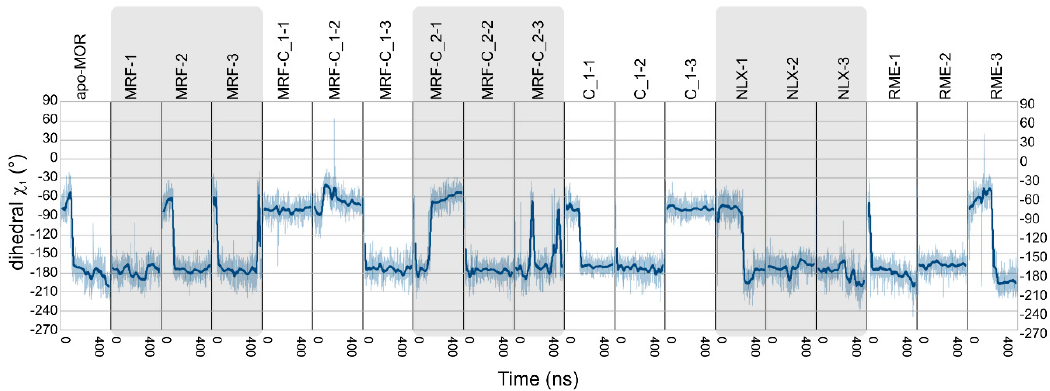
Figure 9. Values of χ 1 dihedral of Tyr 2.64 residue measured in all simulations. Transparent line represents actual values, opaque thick line was added to facilitate analysis and represents a moving average.